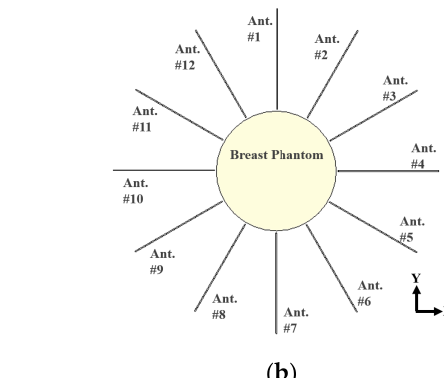
Figure 3. Simulated E-field distribution at 2.45 GHz in the breast phantom derived from a single TSA antenna.